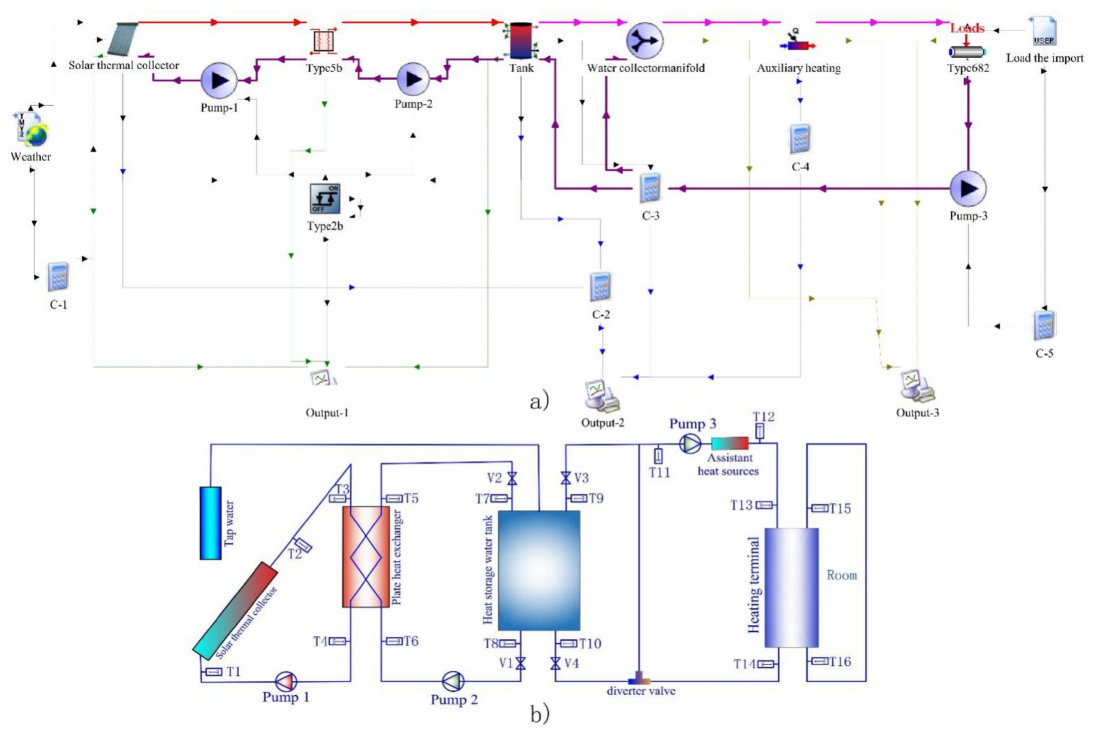
Figure 1. ( a ) TRNSYS dynamic simulation flow chart; ( b ) Structure diagram of solar heating